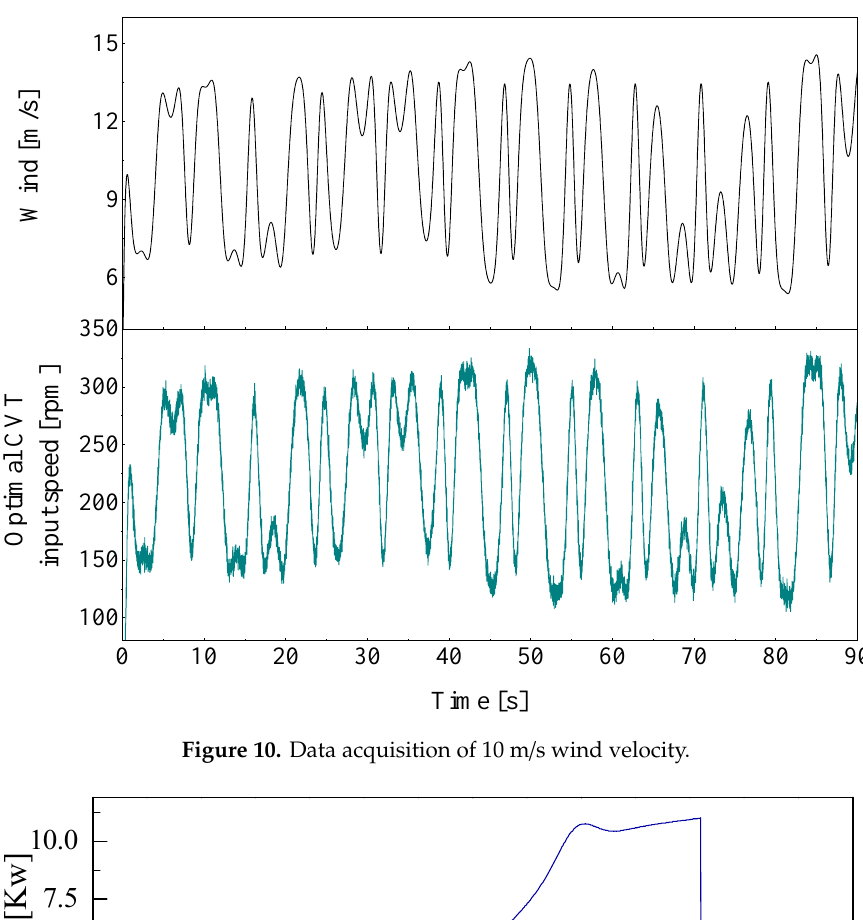
Figure 10. Data acquisition of 10 m / s wind velocity.